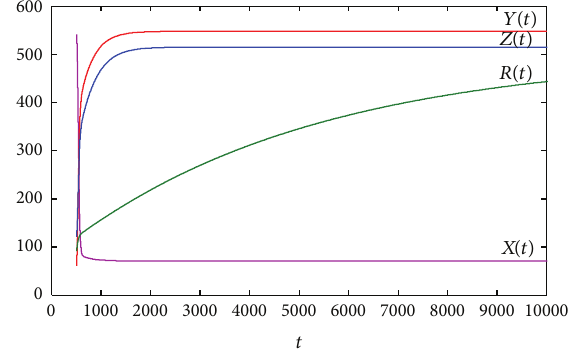
Figure 3: When 𝜀 = 3 , 𝑘 1 = 0.00005 , 𝑘 2 = 0.002 , 𝑘 3 = 0.004 , 𝛽 = 0.00015 , 𝜆 = 0.6 , 𝑘 𝛼 = 0.0015 , 𝜃 = 0.0001 , and 𝑅